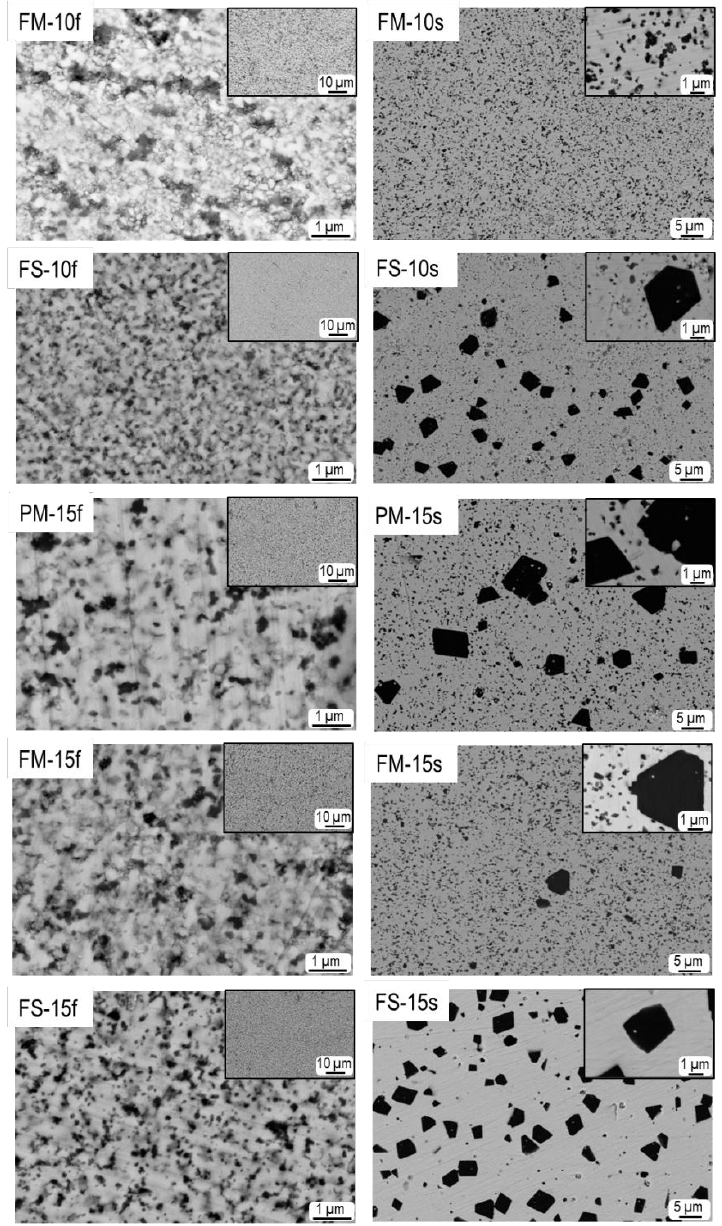
Figure 2. Back‐scattered scanning electron microscopy (SEM) images of polished cross sections of the sintered samples.